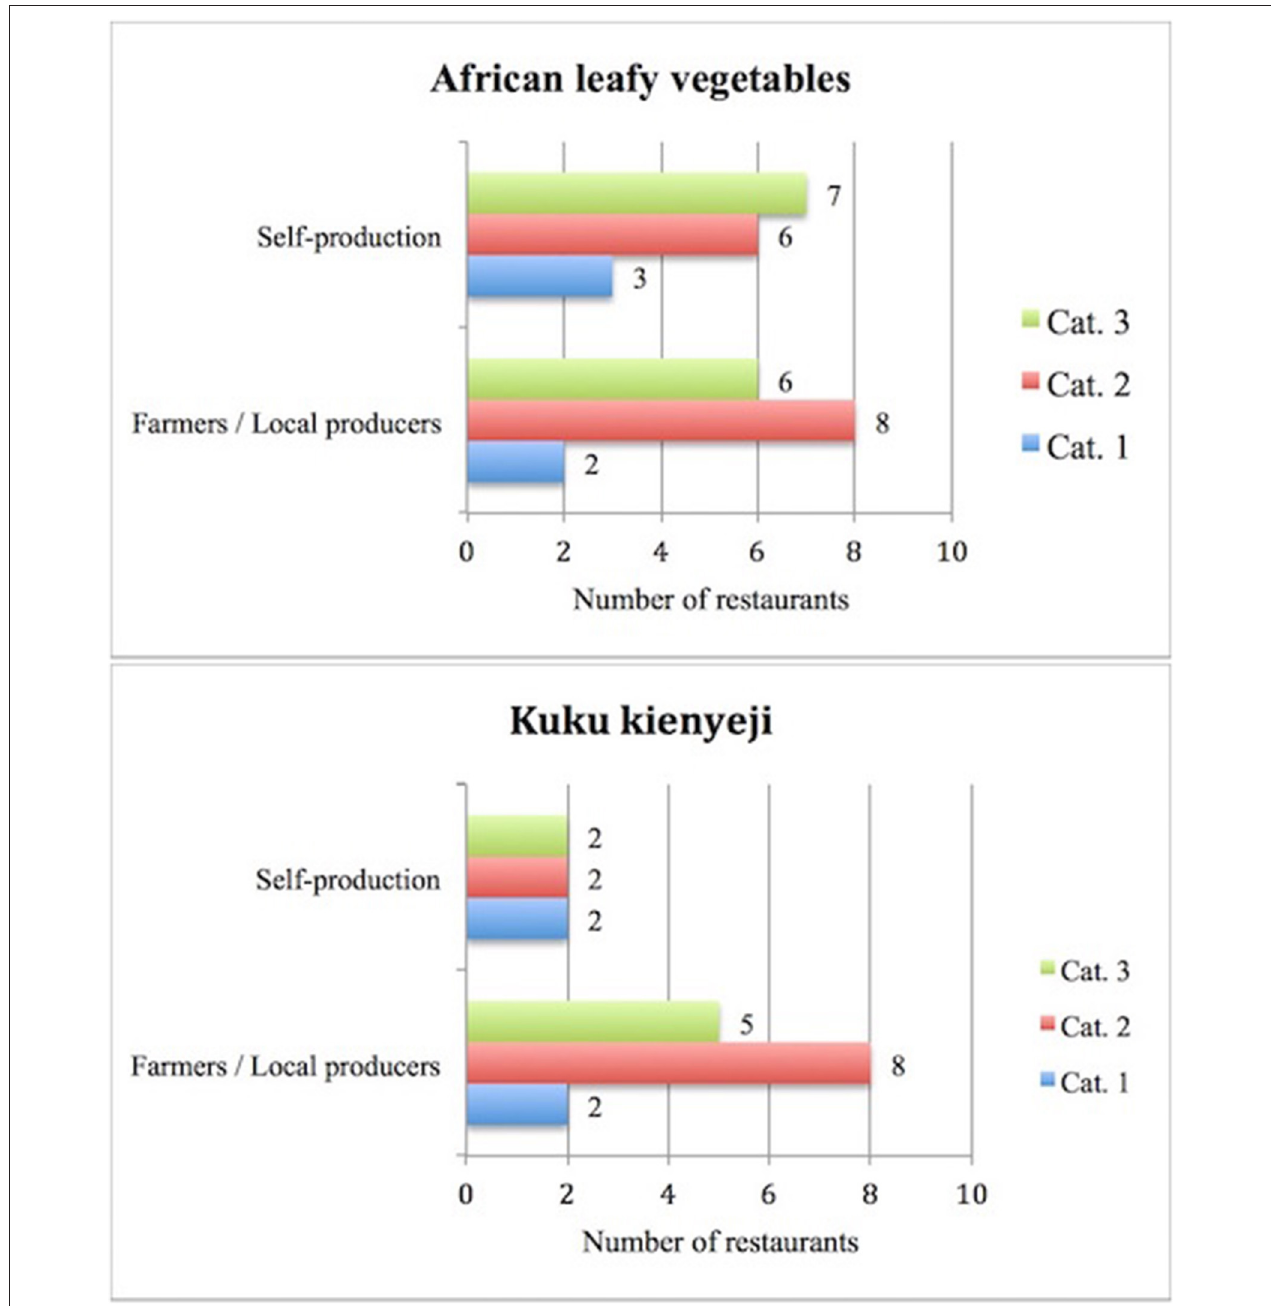
FIGURE 3 | Alternative supply channels for ALV and kuku kienyeji according to the restaurant categories.